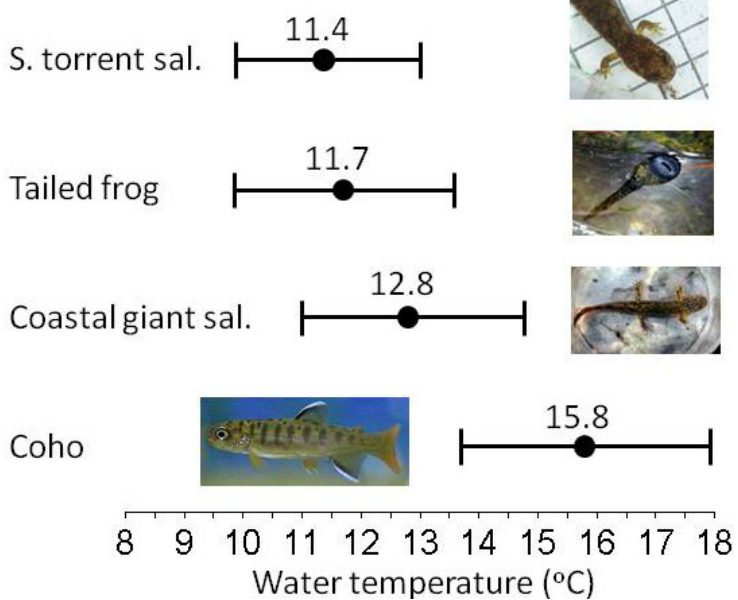
Figure 12. Thermal niches for three headwater stream amphibians and coho salmon. Amphibian thermal niches are based on data from Welsh and Hodgson [66], coho salmon thermal niche determined from Huff et al.